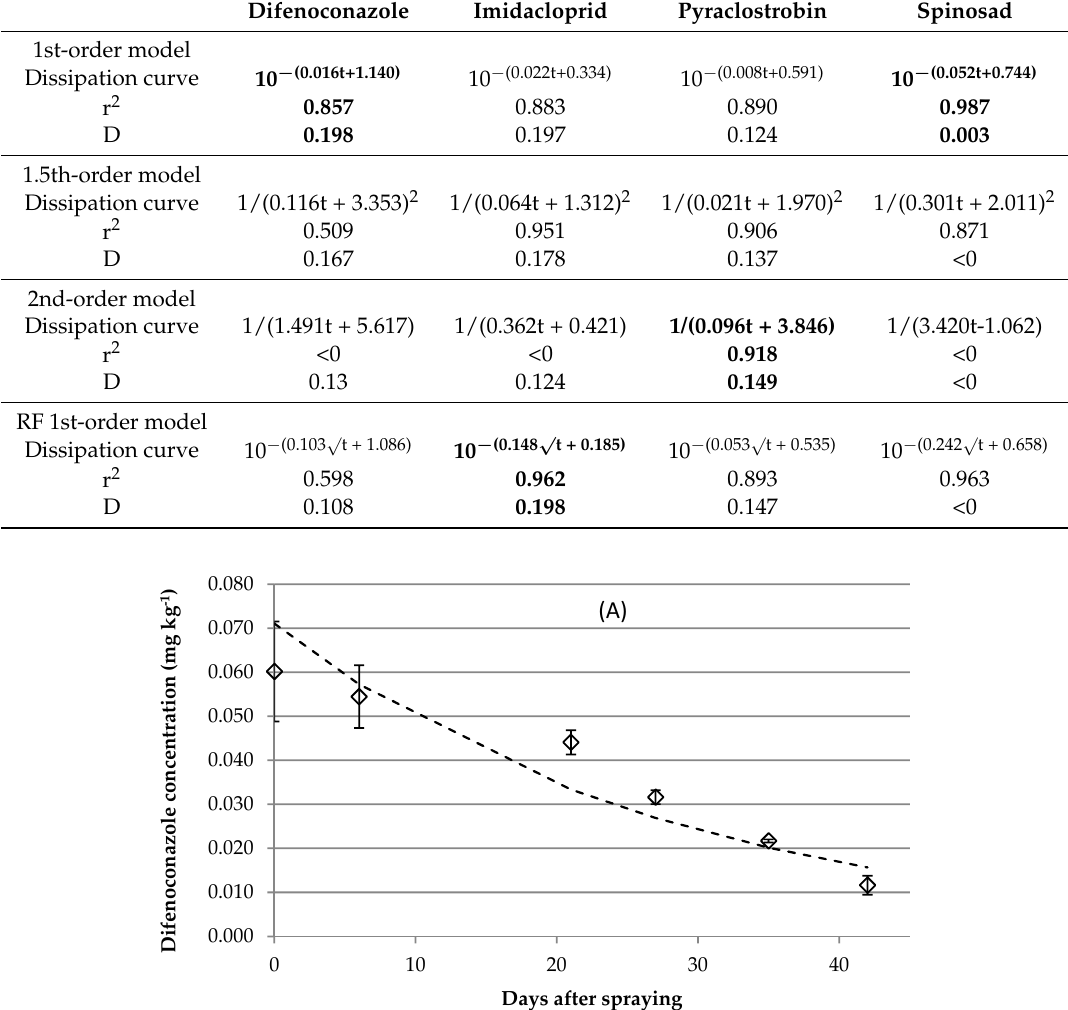
Table 4. The 1st, 1.5th, 2nd, and Root Factor (RF) 1st order model equations that describe the dissipation of difenoconazole, imidacloprid, pyraclostrobin and spinosad in Clementine mandarin. The Best fitting model for each pesticide are in bold font.